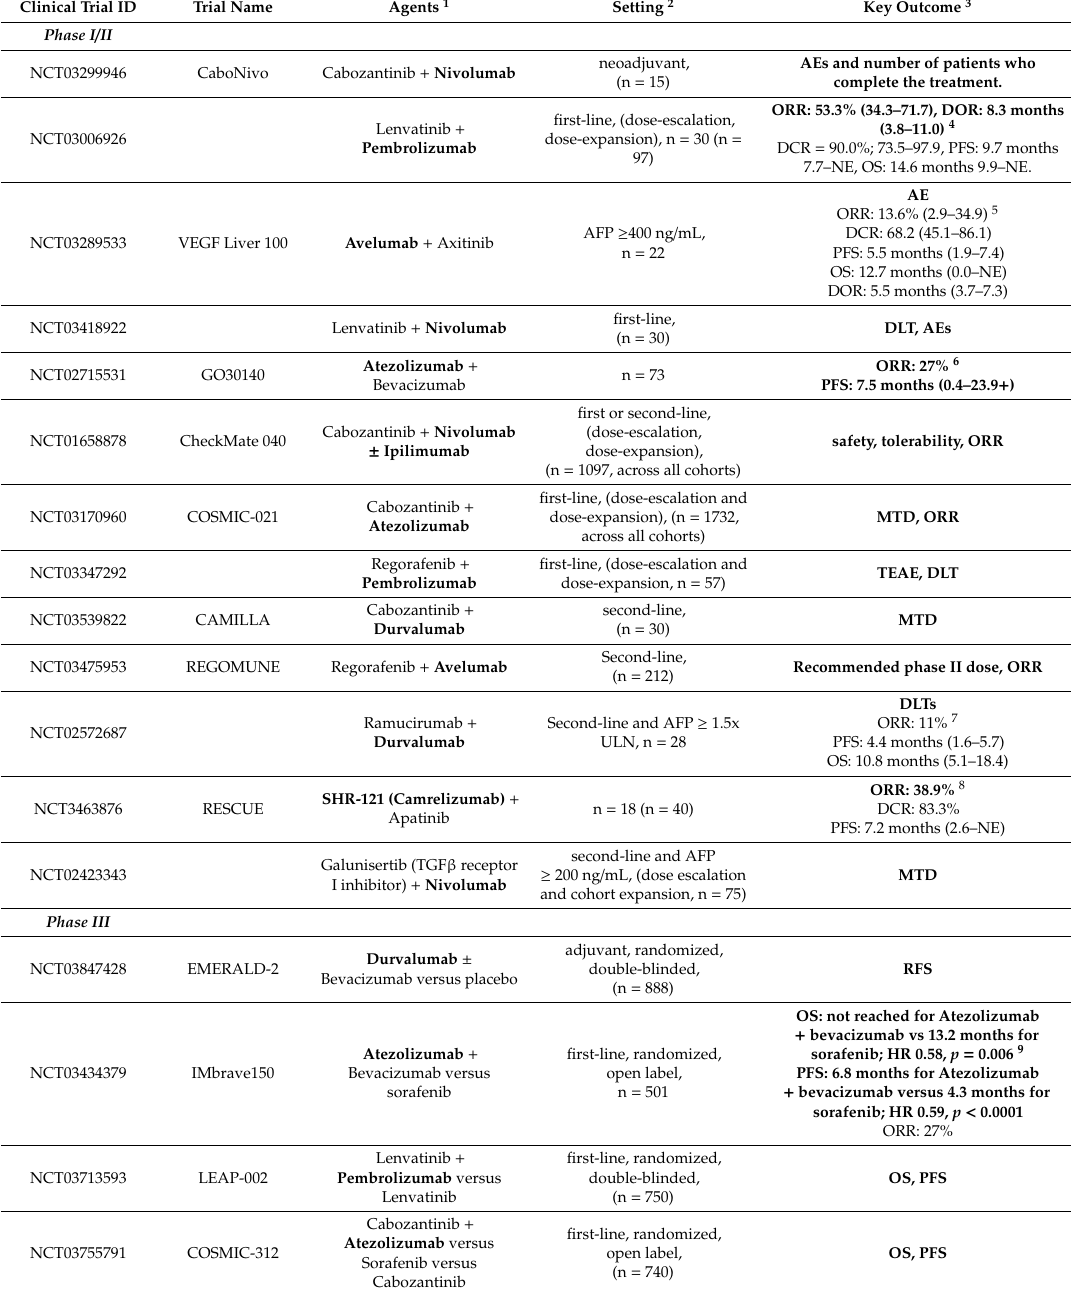
Table 3. Clinical trials and outcomes of the combination therapies with immune checkpoint inhibitors and molecular targeted